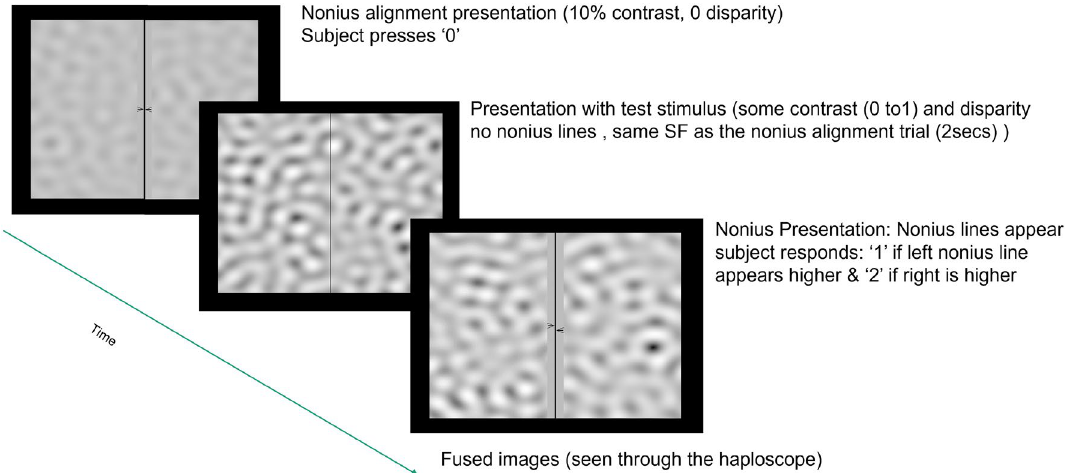
Figure 8. Sequence of events in a trial in the steady noise nonius discrimination experiment. After visually confirming that the nonius marks were aligned , subjects hit a key and viewed the disparate stimulus without nonius lines for 2 s to allow the eyes time to respond. The nonius marks then reappeared and the subject responded with another keystroke to indicate the perceived offset.